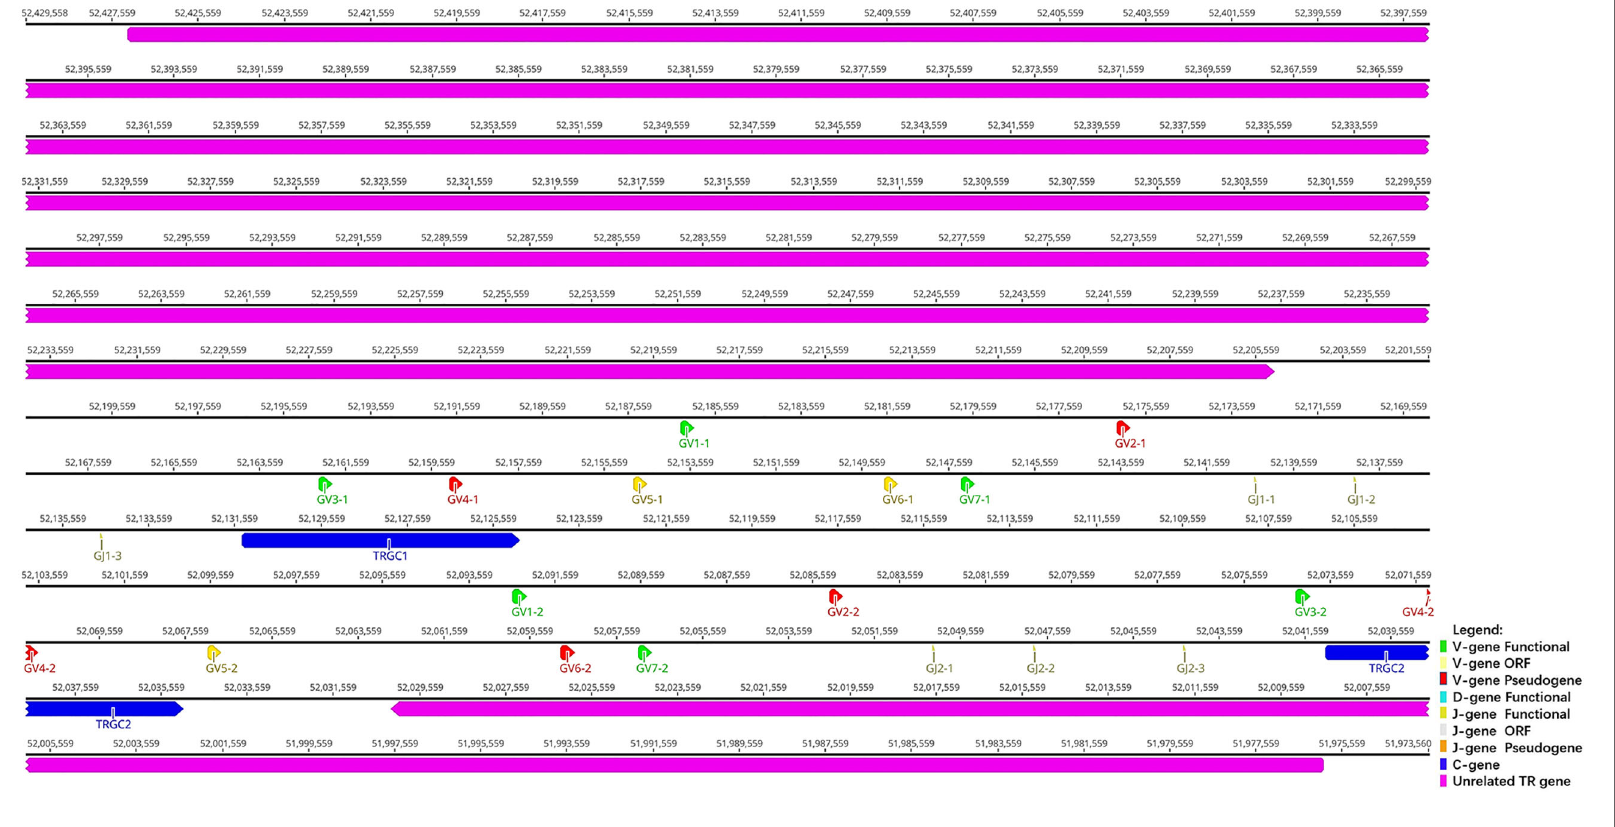
FIGURE 3 | The schematic representation of the genomic organization of the bat TRG locus. The diagram shows the position of all the related and unrelated TRG genes according to nomenclature. The L-part and RSSs are not shown. The arrows indicate the transcriptional orientation of the genes. The number represents the speci fi c location of the genes in chromosome 20 of Rhinolophus ferrumequinum